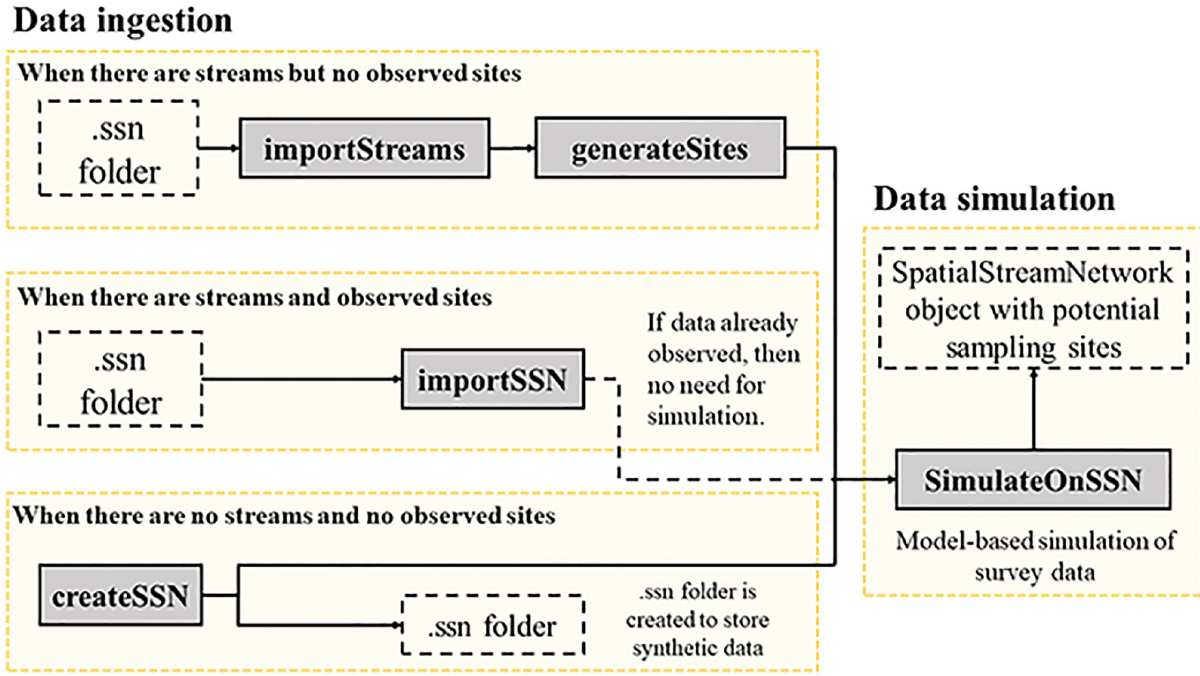
Fig 1. A flow chart of the function calls used to import and prepare streams data for use in SSNdesign . Grey boxes with solid outlines indicate a call to a function (N.B. importSSN and SimulateOnSSN belong to SSN , not SSNdesign ). Clear boxes with dashed outlines indicate a file, folder or R object that is created as a result of a function call. The one dashed line represents an action that will not always be necessary.